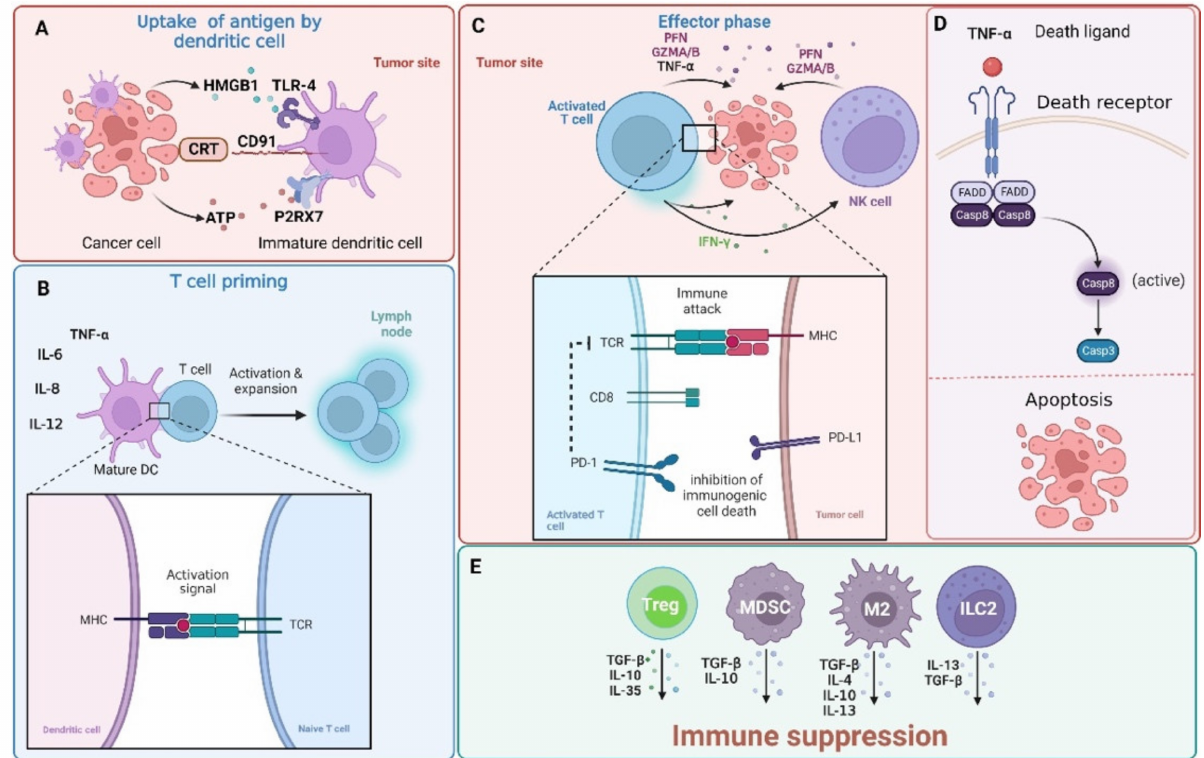
Figure 1. The interaction between tumor cells and immune cells. Tumor cells are detected by adaptive (comprising of B and T cells) and innate immune system (mainly natural killer (NK) cells). Effector CD4+ and cytotoxic CD8+ T cells are capable of recognizing peptide antigens presented on MHC class II or MHC class I, respectively. ( A ) Immunogenic cell death (ICD) is associated with the release of damage-associated molecular patterns (DAMPs) from dying cells. Such molecular patterns, whether expressed on the surface of cells or released outside of the cell, can promote tumor antigen presentation and boost adaptive immunity. Calreticulin (CRT) expressed on cancer cells interacts with the CD91 receptor on dendritic cells (DCs) and high-mobility group protein 1 (HMGB1)—a ligand for the toll-like receptor (TLR-4) receptor on DCs is released by cancer cells. Additionally, ATP released from cancer cells interacts with the P2X purinoceptor 7 (P2RX7) on DSc. ( B ) DCs are required for cytotoxic CD8+ T cell priming. In this process, DCs uptake antigens from tumor cells undergoing apoptosis and with the support of CD4+ helper cells present them to CD8+ T cells. Moreover, DCs can secrete tumor necrosis factor α (TNF- α ,) and interleukins (IL-6, IL-8, and IL-12) that help to trigger the anticancer immune response. ( C ) Activated CD8+ T cells can kill cancer cells through the release of granzyme A/B (GZMA/B), perforins (PFN), or interferon gamma (INF γ ) and TNF α that ( D ) induce cell death through the activation of the extrinsic apoptosis pathway. The extrinsic pathway is triggered with the binding of certain ligands to the TNF α receptor super family. This leads to the oligomerization of the receptor and activation of procaspase-8 through the recruitment of adaptor proteins and the formation of a death-inducing signaling complex (DISC). ( E ) Cancer cells reshape the tumor immune microenvironment into an immunosuppressive surrounding that is rich in regulatory T cells (Tregs), myeloid-derived suppressor cells (MDSCs), group 2 innate lymphoid cells (ILC2s), and tumor-associated macrophages (M2) that release immunosuppressive interleukins (IL-4, IL-10, IL-13, and IL-35) or transforming growth factor β (TGF- β ) and up-regulate receptors (such as programmed cell death 1 ligand 1 (PD-L1)) that “hide” tumor cells from the immune recognition (not shown here). This topic has been extensively reviewed in [15–17] and will not be discussed in detail here. Casp—caspase; FADD—FAS-associated death domain protein; TCR—T-cell receptor. Created with BioRender.com accessed on 1 February